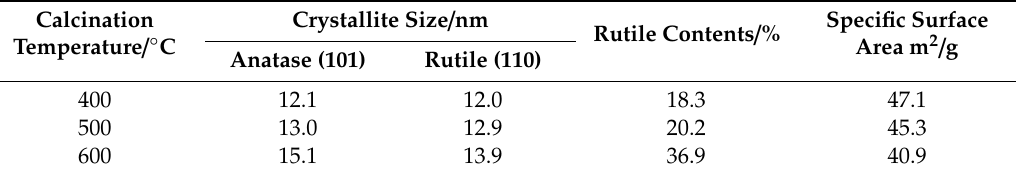
Figure 1. XRD patterns of TiN, P25, and N-doped TiO 2 obtained at different calcination temperatures. Table 1. Crystallite sizes, rutile ratios, specific surface area of samples obtained at different temperature.